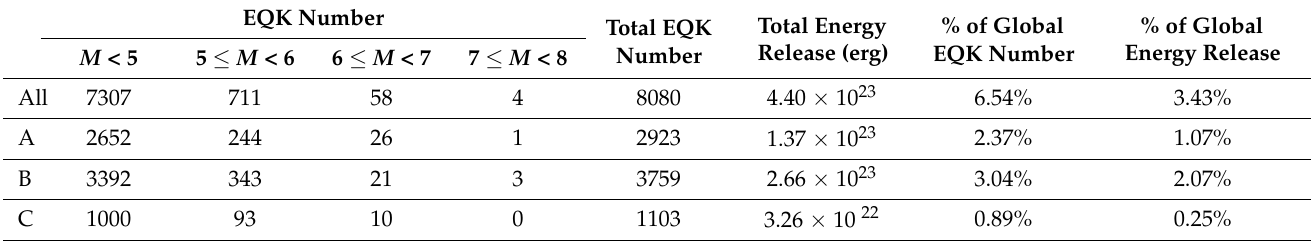
Table 1. Earthquake number and energy of M ≥ 2.5 within 110–130 ◦ E in